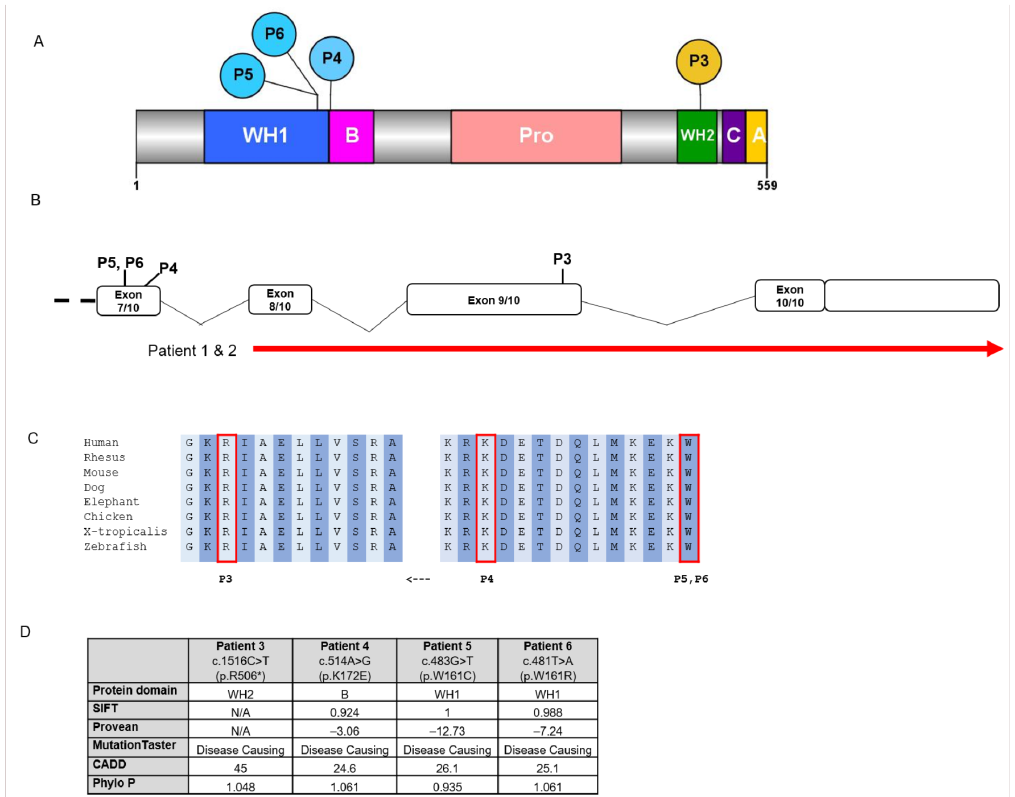
Figure 1. Schematics depicting location of WASF1 variants and evidence of pathogenicity of the WASF1 single nucleotide variants (SNVs). ( A ) Scheme 1 protein and the locations of the SNVs in P3–P6. Blue circles denote missense variants, and the yellow circle denotes the nonsense variant. Abbreviations of domains: WASP homology 1 domain (WH1, in blue), Basic domain (B, in magenta), Proline-rich region (Pro, in salmon pink), WASP homology 2 domain (WH2, in green), Cofilin homology domain (C, in purple), Acidic domain (A, in yellow). ( B ) Schematic diagram showing the 3 (cid:48) end of WASF1 . Red line indicates the deletion in P1 and P2, which includes exons 8–10 of WASF1 and extends beyond the 3 (cid:48) end of the gene. ( C ) Schematic diagram depicting conservation throughout various species of WASF1 amino acids including and surrounding the missense variants identified in this report. ( D ) Table summarizing protein domains and results of in silico pathogenicity prediction tools for the four single nucleotide variants, which are described in reference to RefSeq transcript